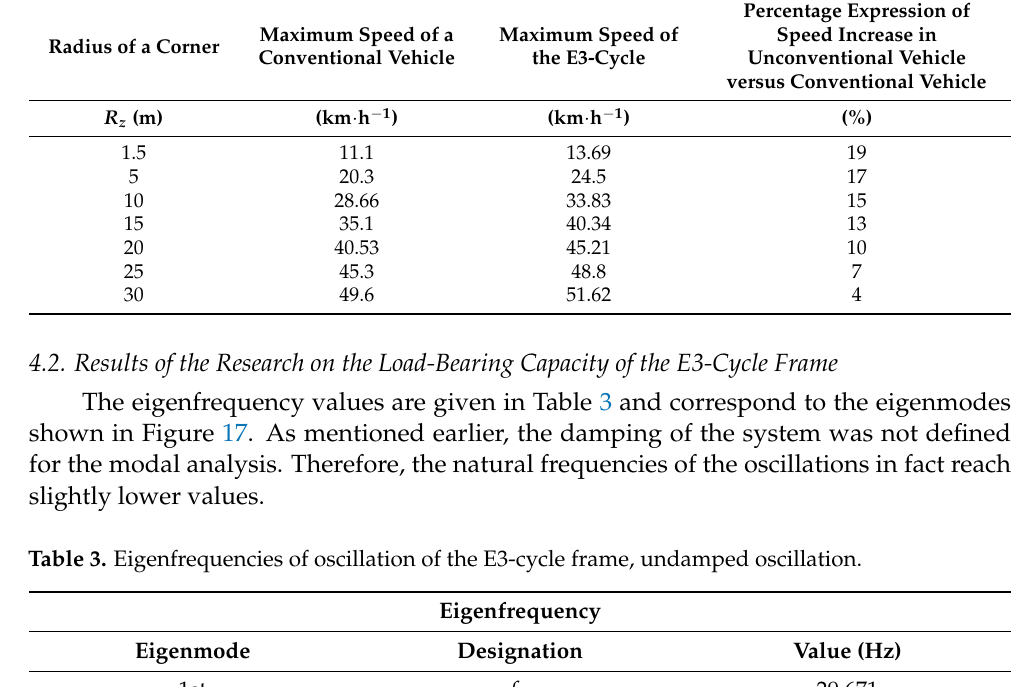
Radius of a Corner